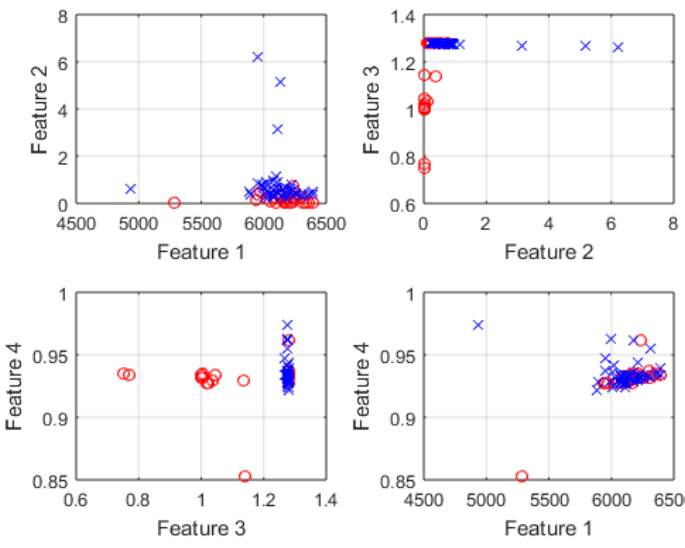
Figure 10. Four example plots of different features plotted against each other. The free hand motion features are shown as blue crosses, while the bag carrying features are shown as red circles.